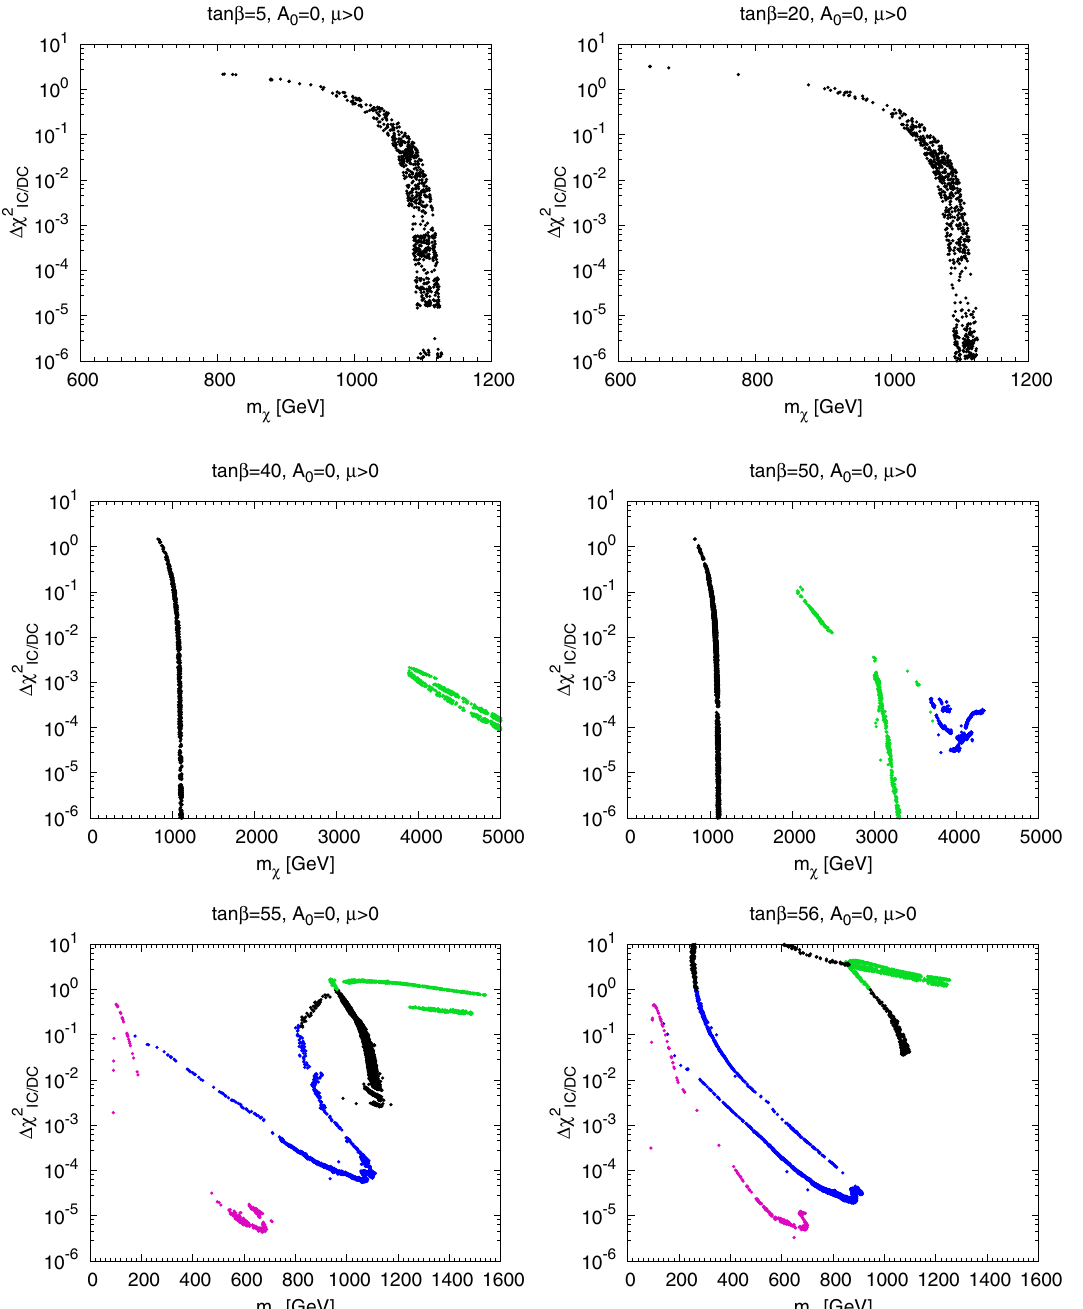
Fig. 13 Contributionstotheglobal χ 2 likelihoodfunctionfromacom- parison of the IceCube upper limit on the muon flux generated by ener- getic neutrinos produced by WIMP annihilations in the core of the